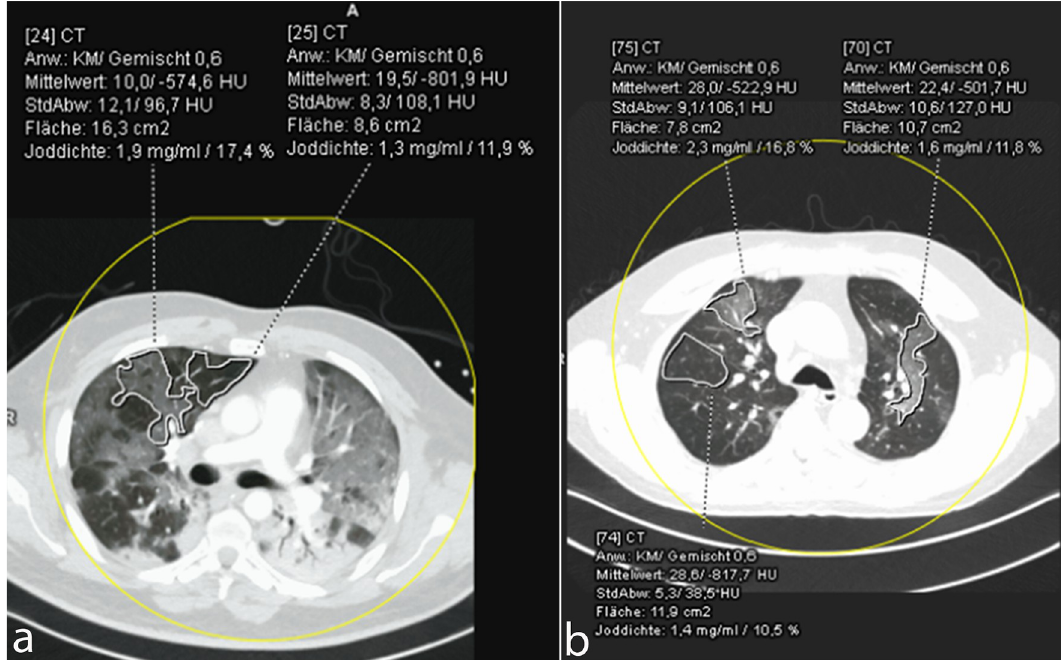
Fig 2. Iodine uptake in normally aerated lung and ground-glass opacifications (two different patients, a) and b). Ground-glass opacifications demonstrated a higher iodine density as compared to normally aerated lung.